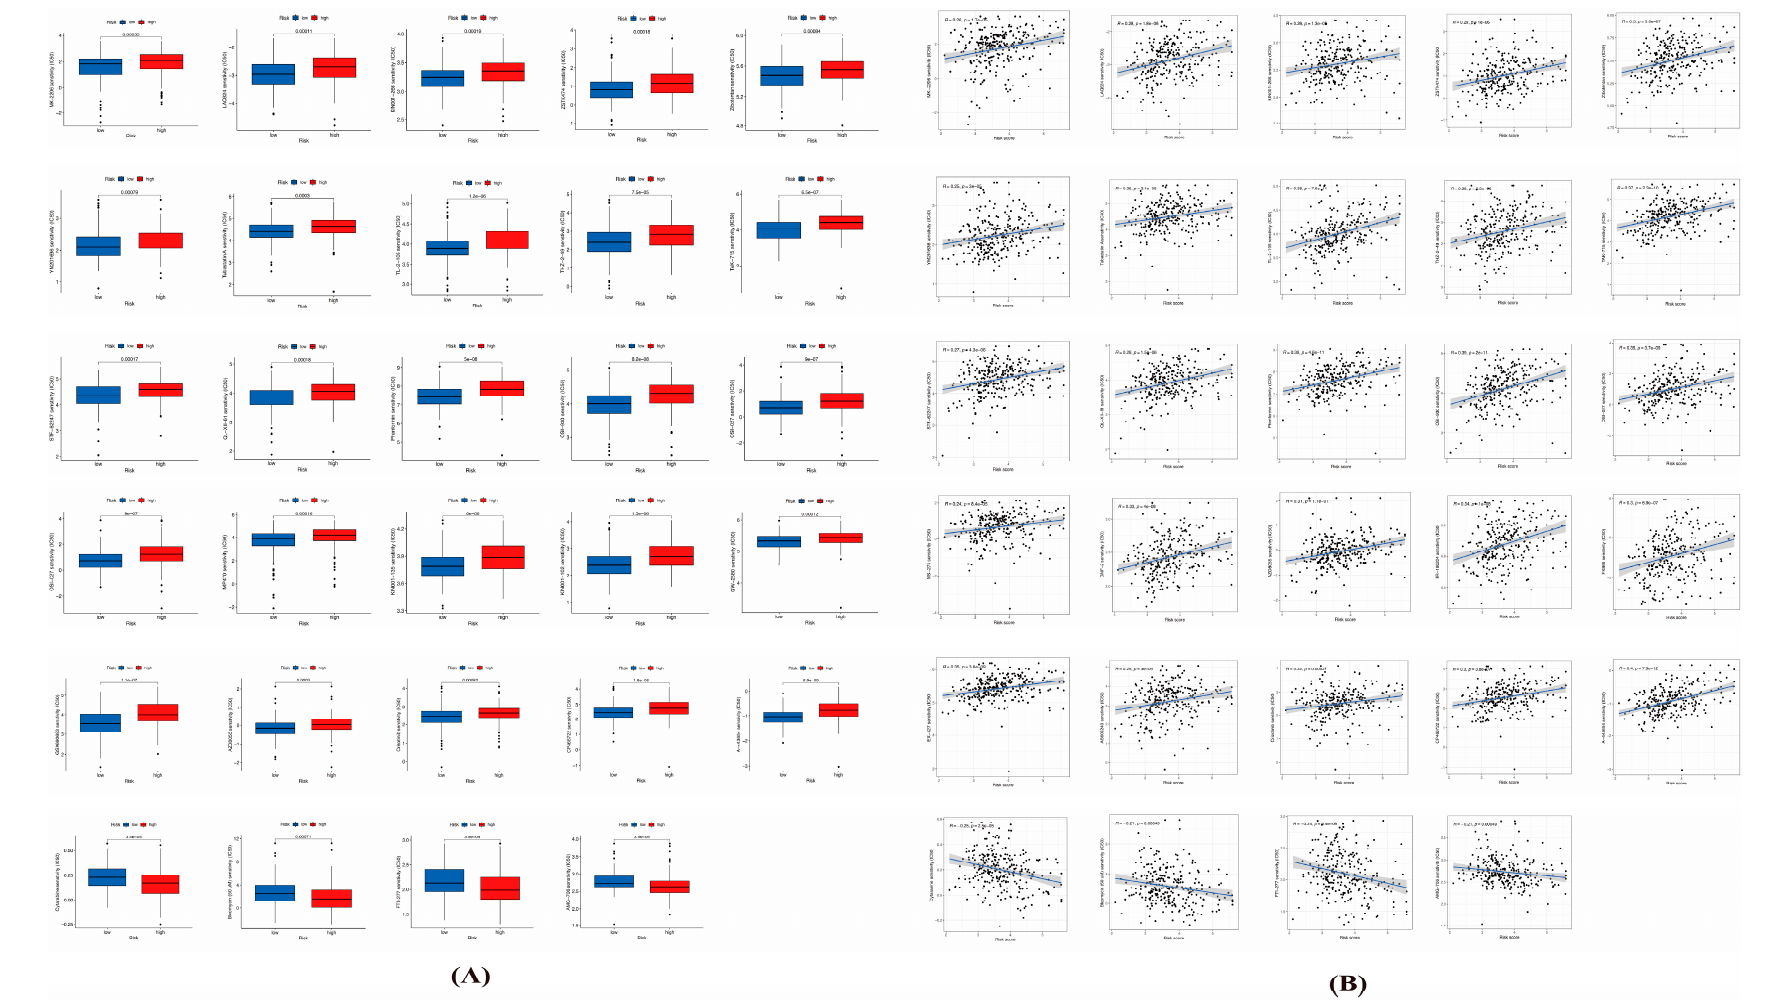
Figure 6. The relationships between the risk scores and drug sensitivity. ( A ) The box plot depicts the drug sensitivity for the different risk groups. ( B ) The correlation between the risk scores and drug sensitivity was evaluated by Spearman